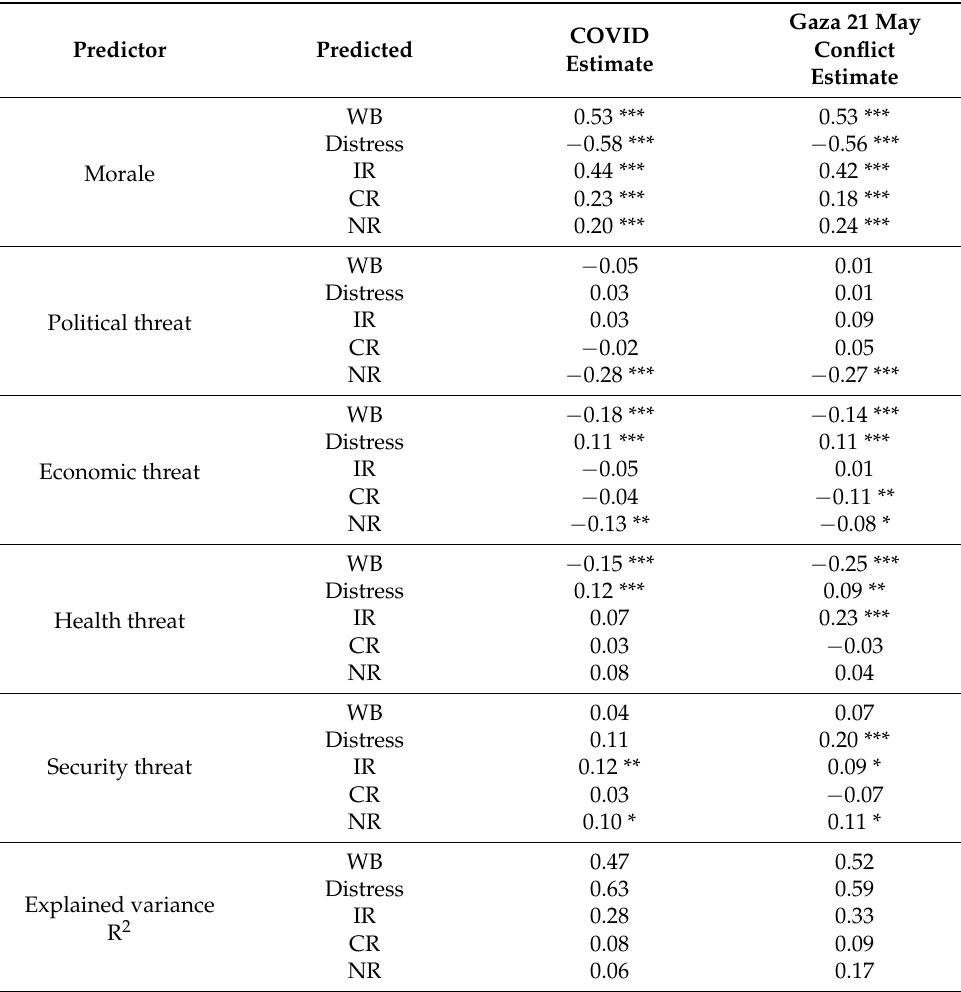
Table 2. Standardized estimates of path analyses of four types of threats and morale predicting distress; well-being; and individual, community, and national resilience during COVID-19 ( n = 699) and Gaza 21 May conflict ( n =